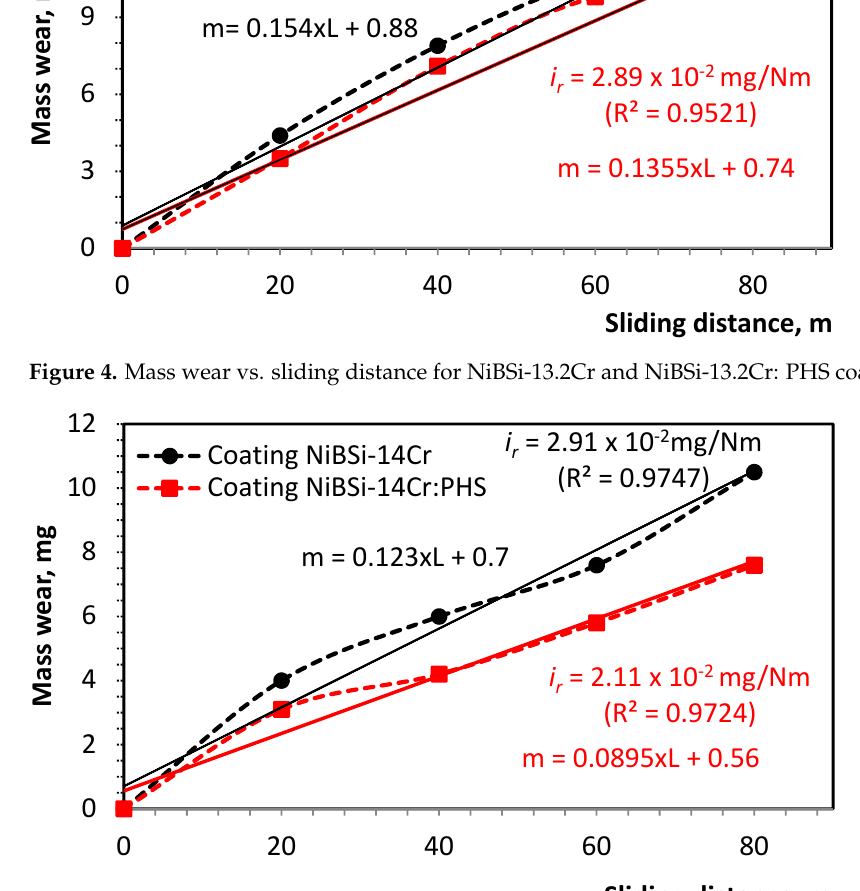
Figure 6. Mass wear vs. sliding distance for NiBSi-16Cr and NiBSi-16Cr: PHS coatings.